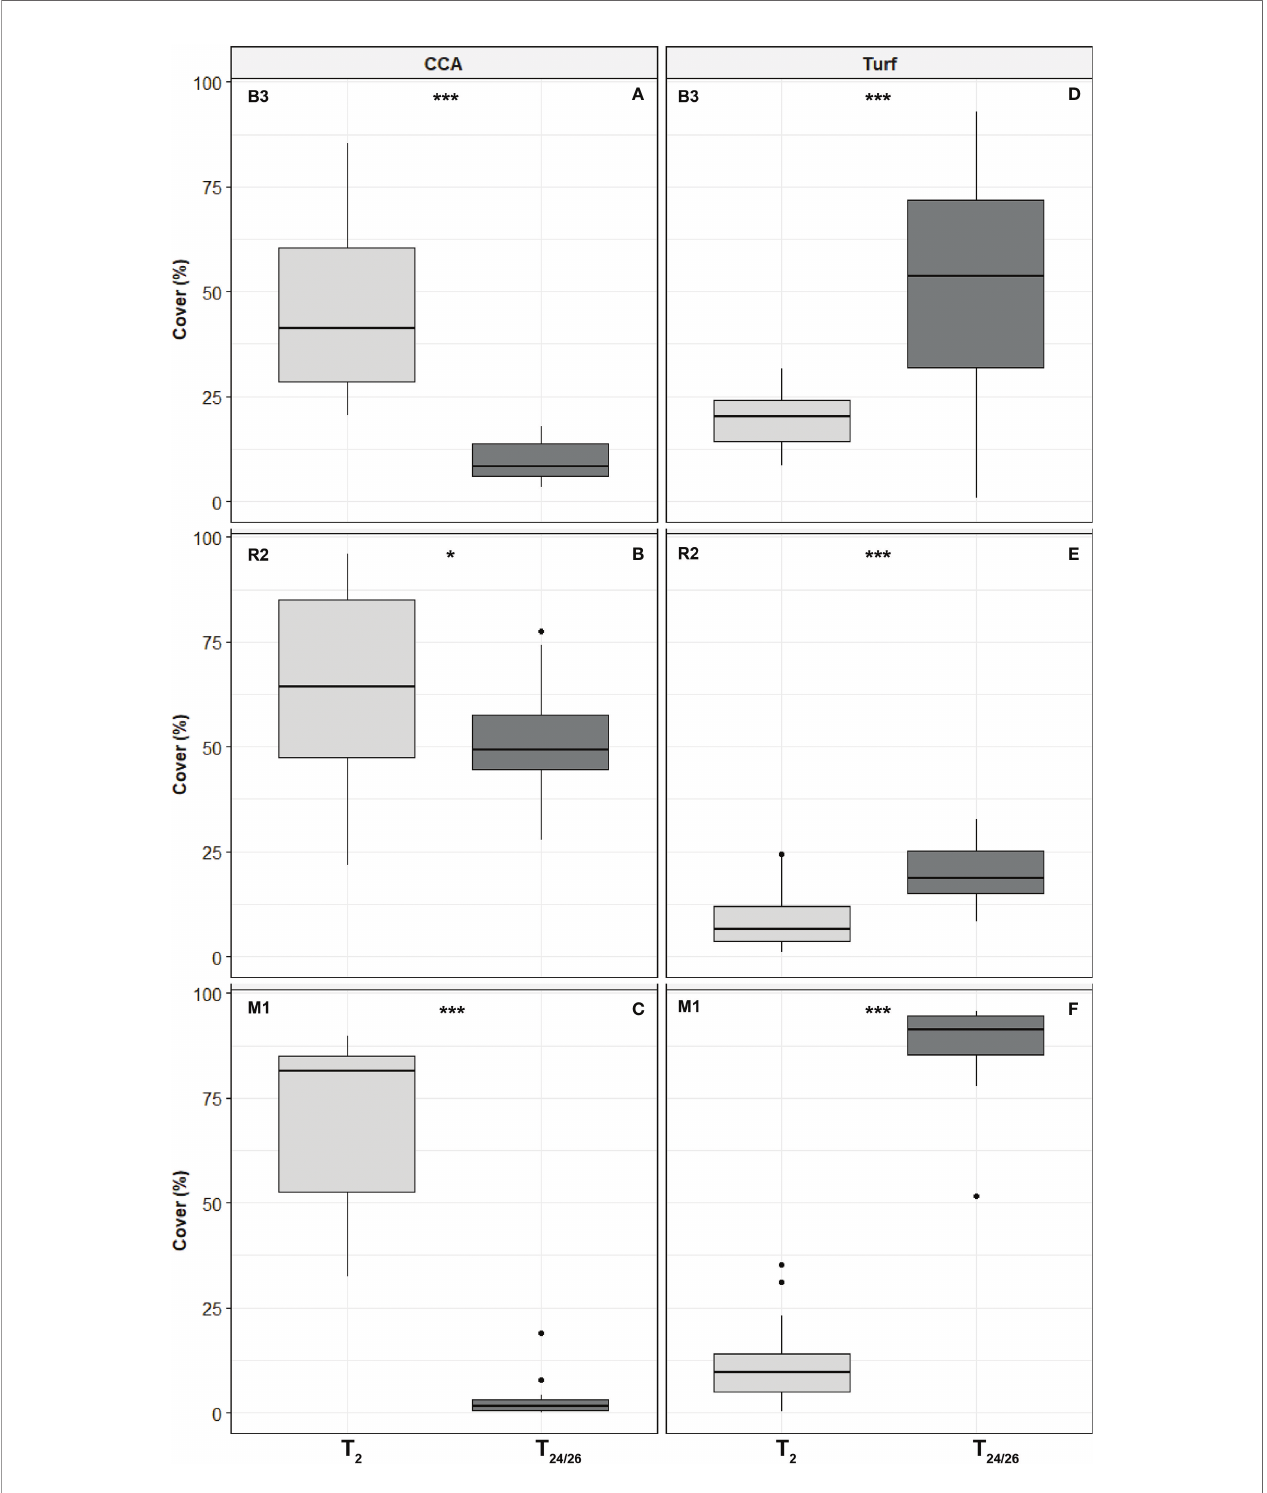
FIGURE 3 | Change in crustose coralline algae (CCA) (A – C) and Turf percent cover (D – F) on top sides of the tiles between the beginning (two months after the time of deployment, T 2 ) and the end (after ca two years of deployment, T 24/26 ) of collector deployment at study stations B3, R2 and M1 (number of tiles n = 15, 20 and 19, respectively). Data are median values ± 25 th and 75 th percentiles (box), minimum and maximum values (whiskers), and outliers (dots). Stars represent statistical signi fi cance (see Table 2